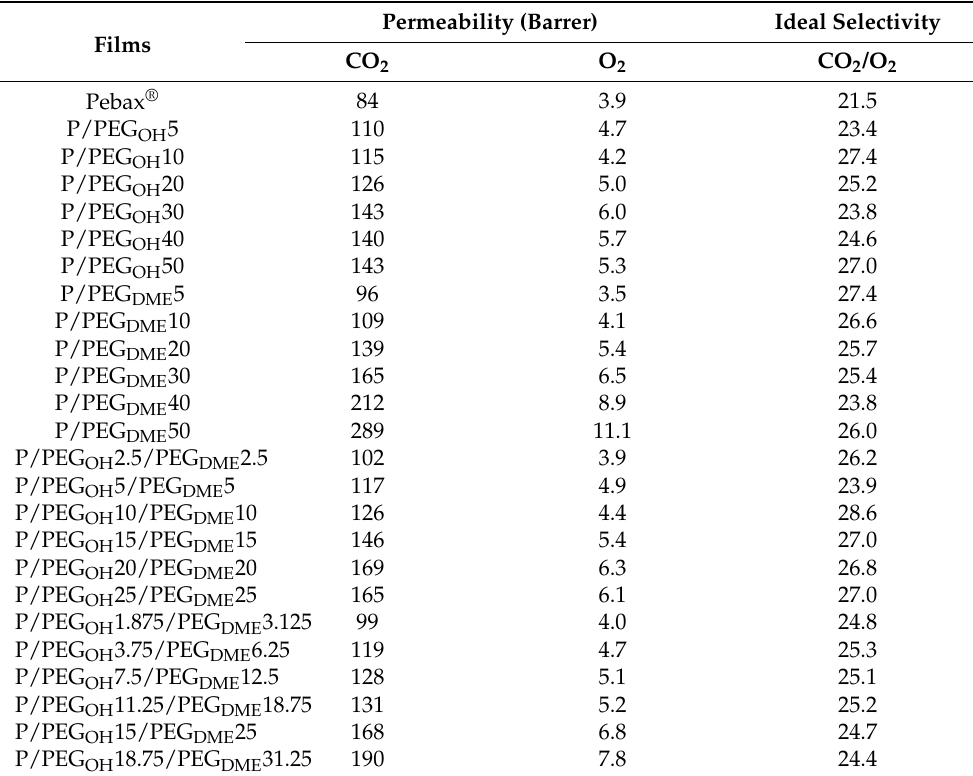
Table 3. CO 2 and O 2 permeability coefficients and ideal CO 2 /O 2 selectivity of the pristine Pebax ® , the Pebax ® /PEG OH films, the Pebax ® /PEG DME films, and the Pebax ® /PEG OH /PEG DME films (the standard deviation is greater than 10% for the permeability values and greater than 20% for the selectivity